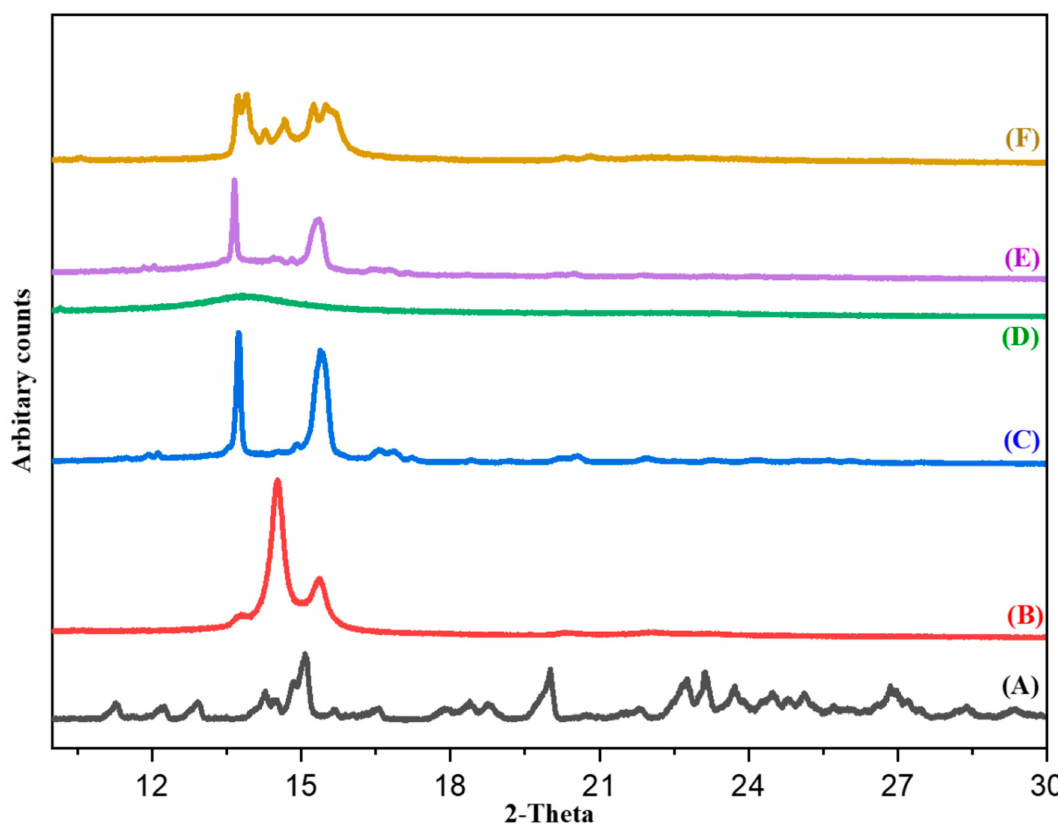
Figure 7. Representing the PXRD patterns of ( A ) XH, ( B ) CE, ( C ) Pluronic F-68 (PF-68), ( D ) Lipoid E 80SN (LE-80), ( E ) XH-SLNs and ( F )